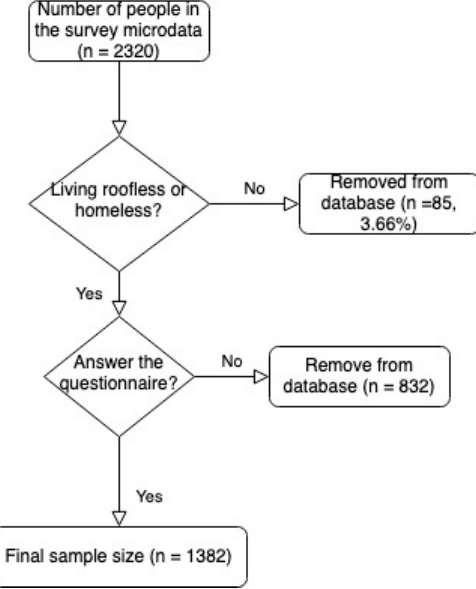
Figure 1. Flow diagram of survey participants.